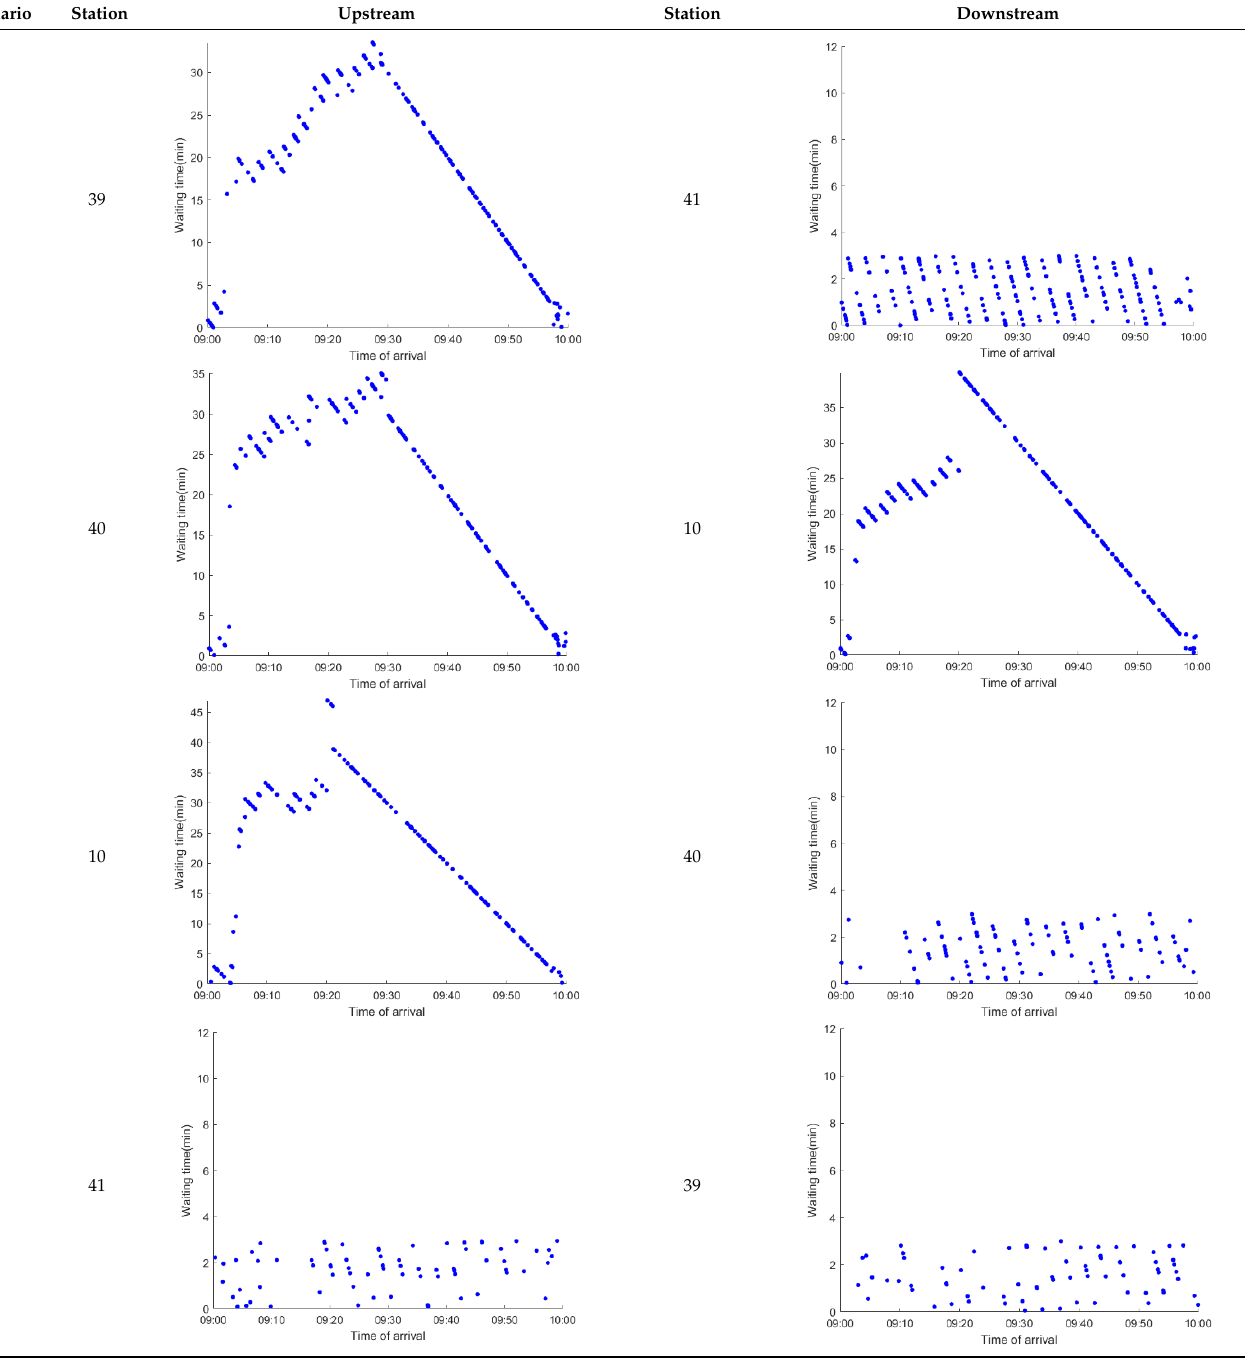
10 Table 12. Distribution of waiting time per bus passenger in Scenario B.